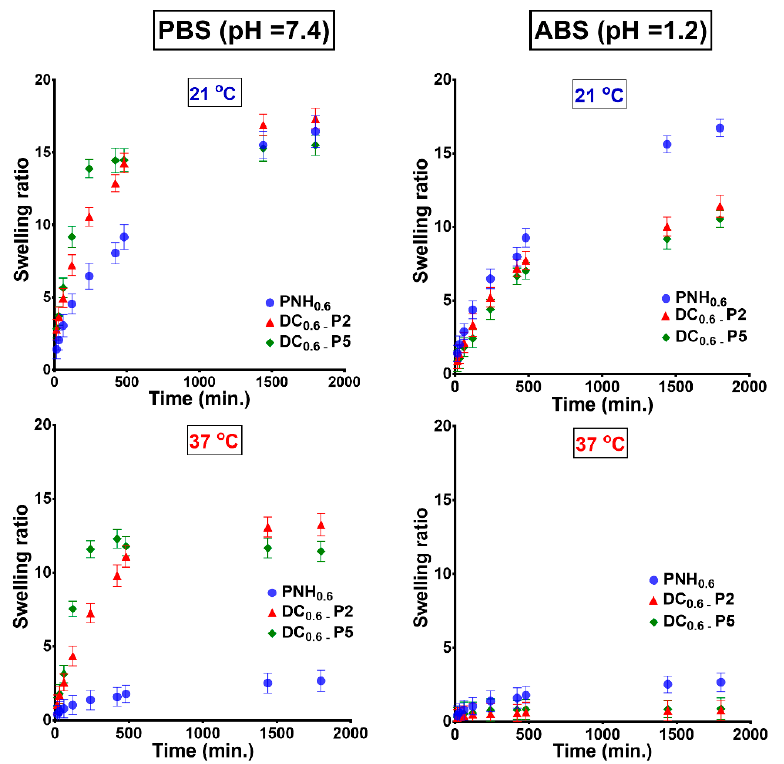
Figure 6. Swelling kinetics of conventional and double cross-linked hydrogels determined in buffer solution at pH 7.4 and pH 1.2 at 21 and 37 °C.